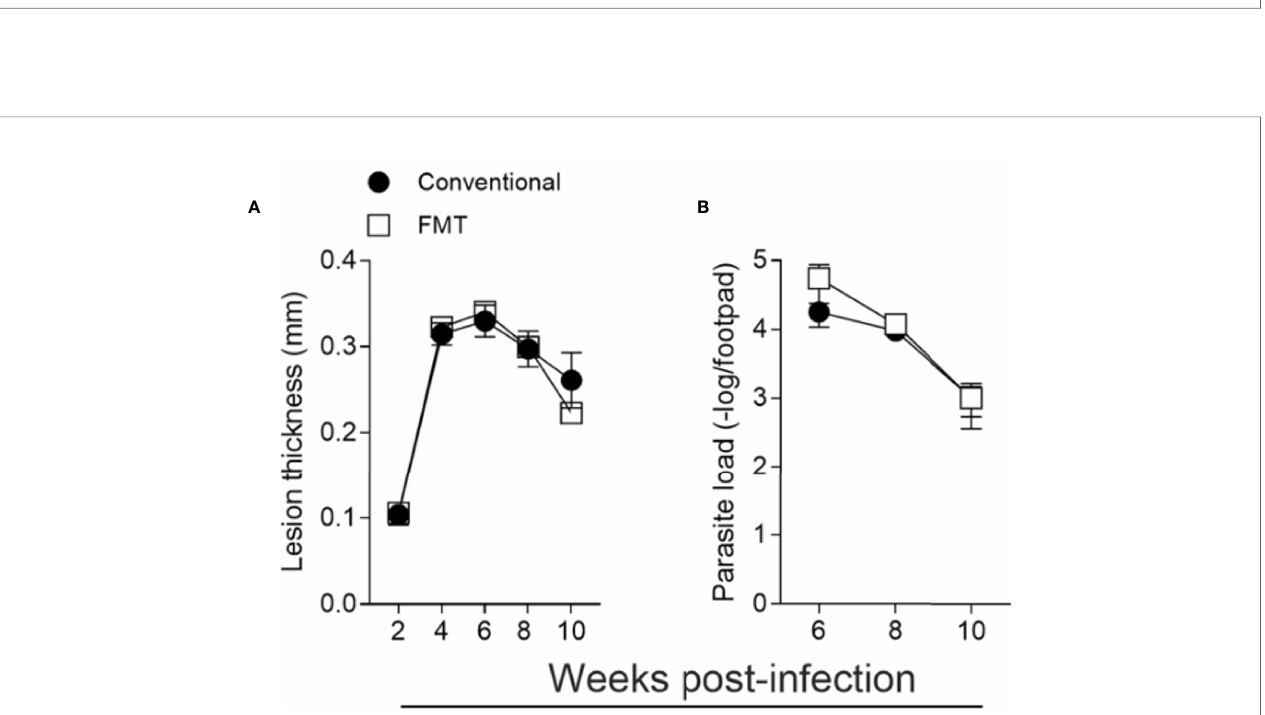
FIGURE 8 | Microbiota is essential for the control of L. major infection. GF mice were conventionalized by fecal transfer and co-housing as described in Methods . (A) Lesion thickness in footpad was monitored every two weeks up to 10 weeks post infection. (B) Quanti fi cation of parasite load by limiting dilution 6 to 10 weeks post infection. The results are representative of two independent experiments. Four animals were used per group at each time point.